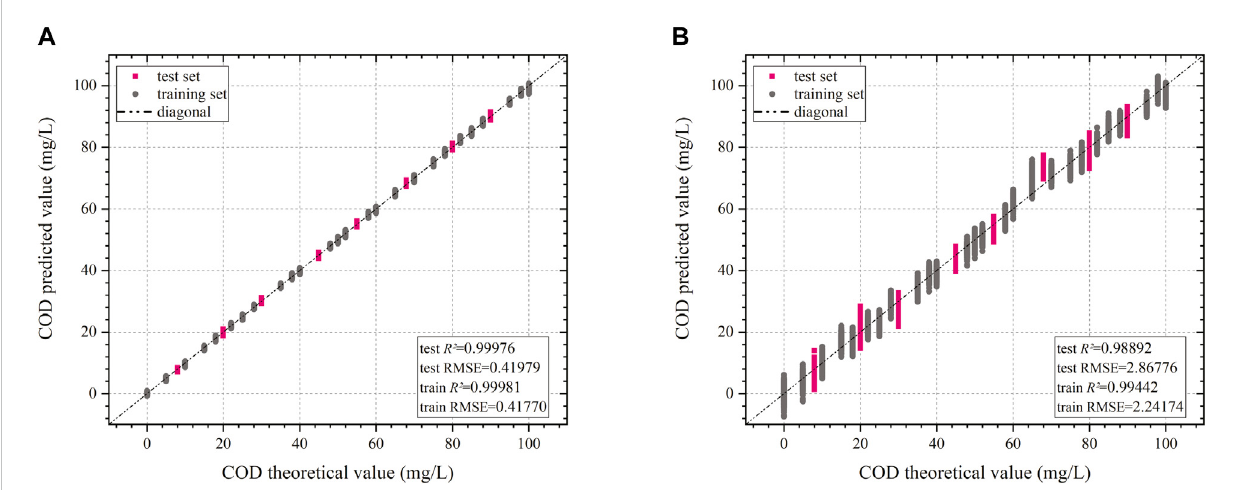
FIGURE 7 Comparison curves between predicted and theoretical COD values in the training set and test set of two models. (A) The model of SVR with 700 feature bands in transmissive detection. (B) The model of MAS and PLSR with 2000 feature bands in re fl ective detection.